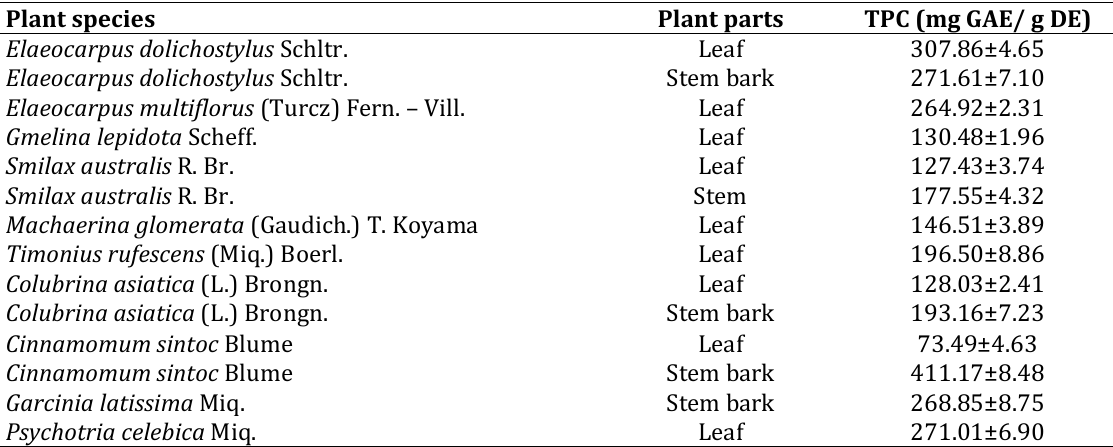
Table II. Total phenolic compounds of selected plant extracts Plant species Plant